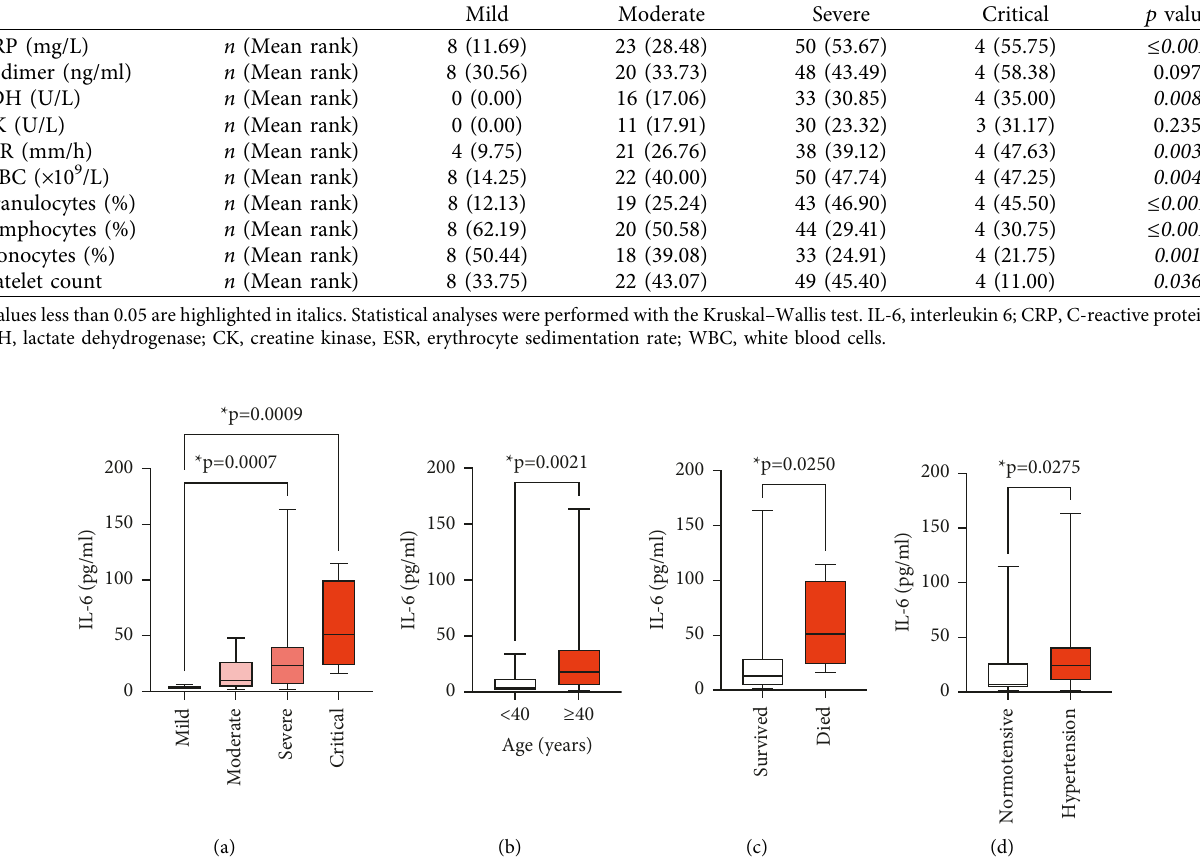
(a) Baseline levels of serum IL-6 were classified into four groups (mild, moderate, severe, and critical). (b) Comparison of mean ranks of IL-6 between patients years and 40 years. (c) Differences in IL-6 between >